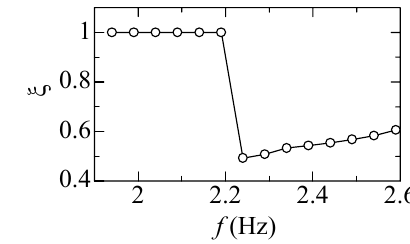
Fig. 10 Dependence of ξ on excitation frequency f for the same condition as